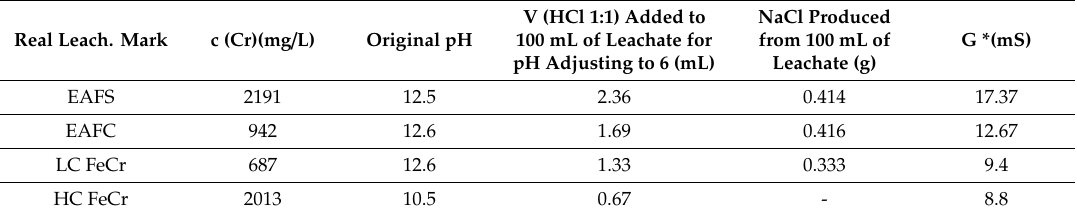
Table 1. Real leachates